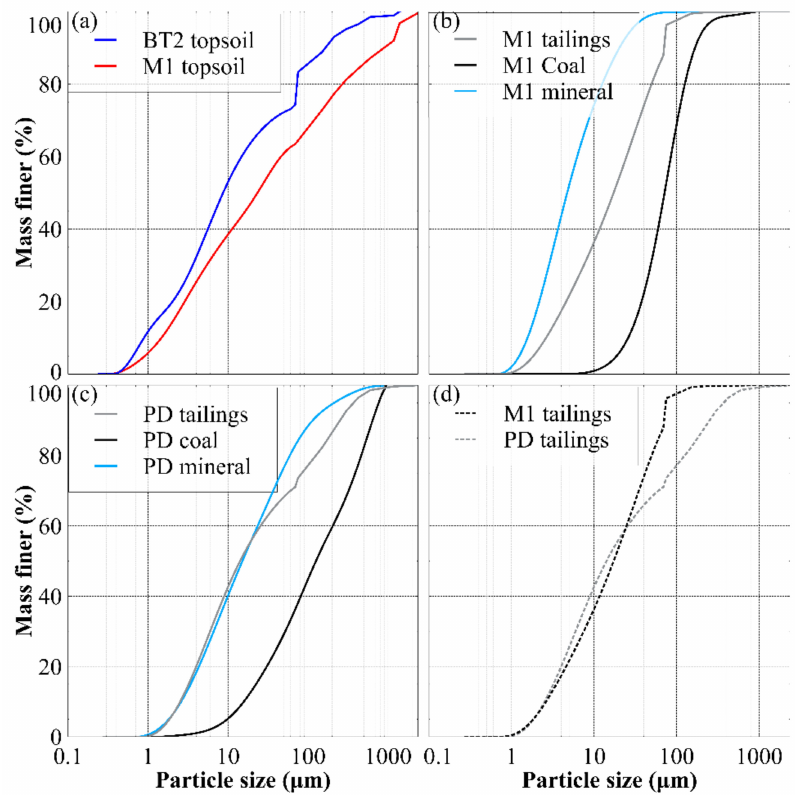
Figure 11. Grain size distributions measured for the topsoils, tailings, and the representative coal and mineral particles separated from each tailings. Subfigure ( a ) shows the similarity between the two topsoils, ( b , c ) show how the representative coal and mineral fractions differ between the tailings, and ( d ) highlights the similarity of the tailings. Particle sizes below 75 µ m were determined by laser diffraction, sizes above 75 µ m was determined by wet